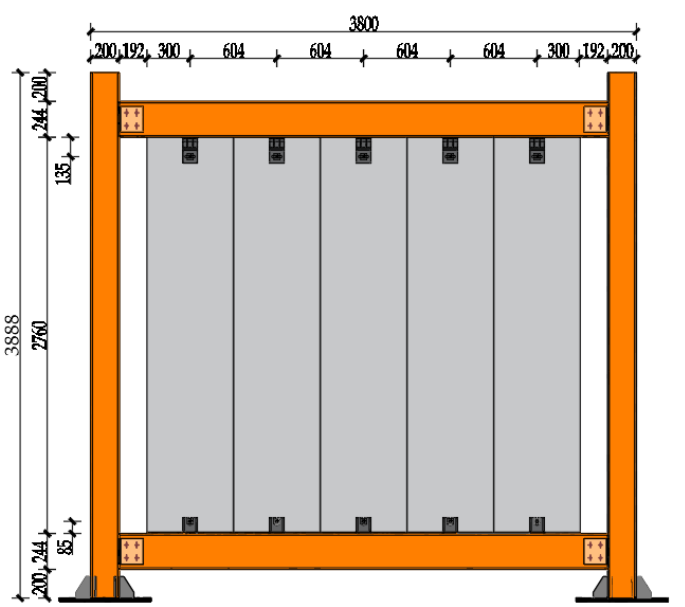
Figure 3. Connector installation dimension schematic (units: mm).